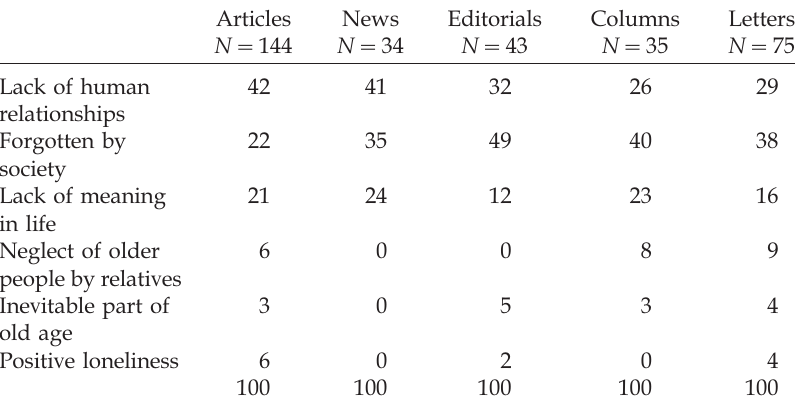
Table 3. Portrayals of old age loneliness